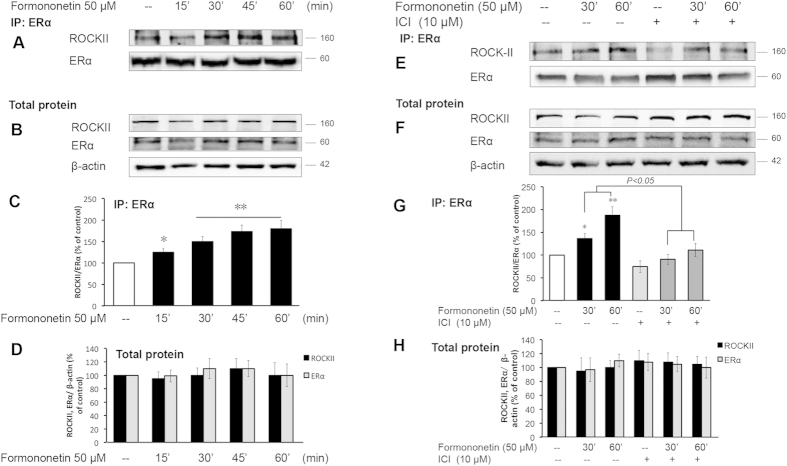
Inhibition of ER activation by ICI 182,780 abolished the interaction between ERα and ROCK-II induced by formononetin.(A–D) HUVECs were treated with 0.1% DMSO or 50 μM formononetin for 15, 30, 45 and 60 min. (E–H) HUVECs were pretreated with 10 μM ICI 182,780 for 2 h, followed by washout and treatment with 0.1% DMSO or 50 μM formononetin for 30 and 60 min. HUVECs protein extracts were immunoprecipitated with anti-ERα antibody and the immunoprecipitations (IPs) were assayed for co-immunoprecipitation of ROCK-II with Western blotting. HUVECs total protein was directly assayed with western blotting analysis as controls. Results are expressed as percentage of control in mean ± (n = 3), *p < 0.05, **p < 0.01 vs. control.